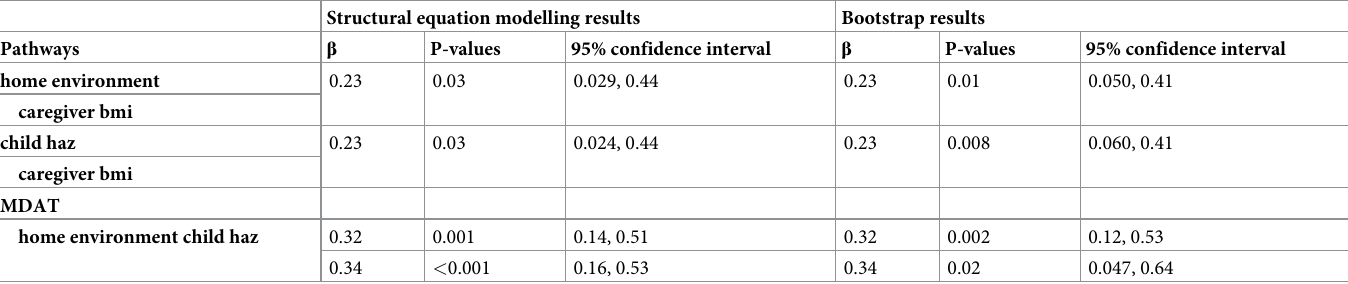
Table 4. Standardized beta-coefficients and bootstrap results for direct pathways between caregiver BMI, the home environment, child nutritional status according to HAZ, and development in children with